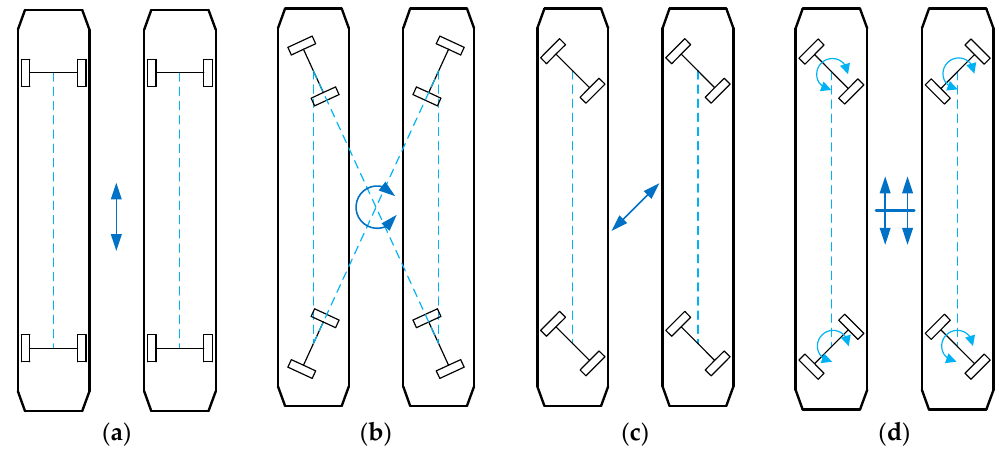
Figure 2. Analysis of motion model. ( a )Forwards/Backwards; ( b ) Rotation; ( c ) Sideways/crab motion; ( d ) Lifting and laying.